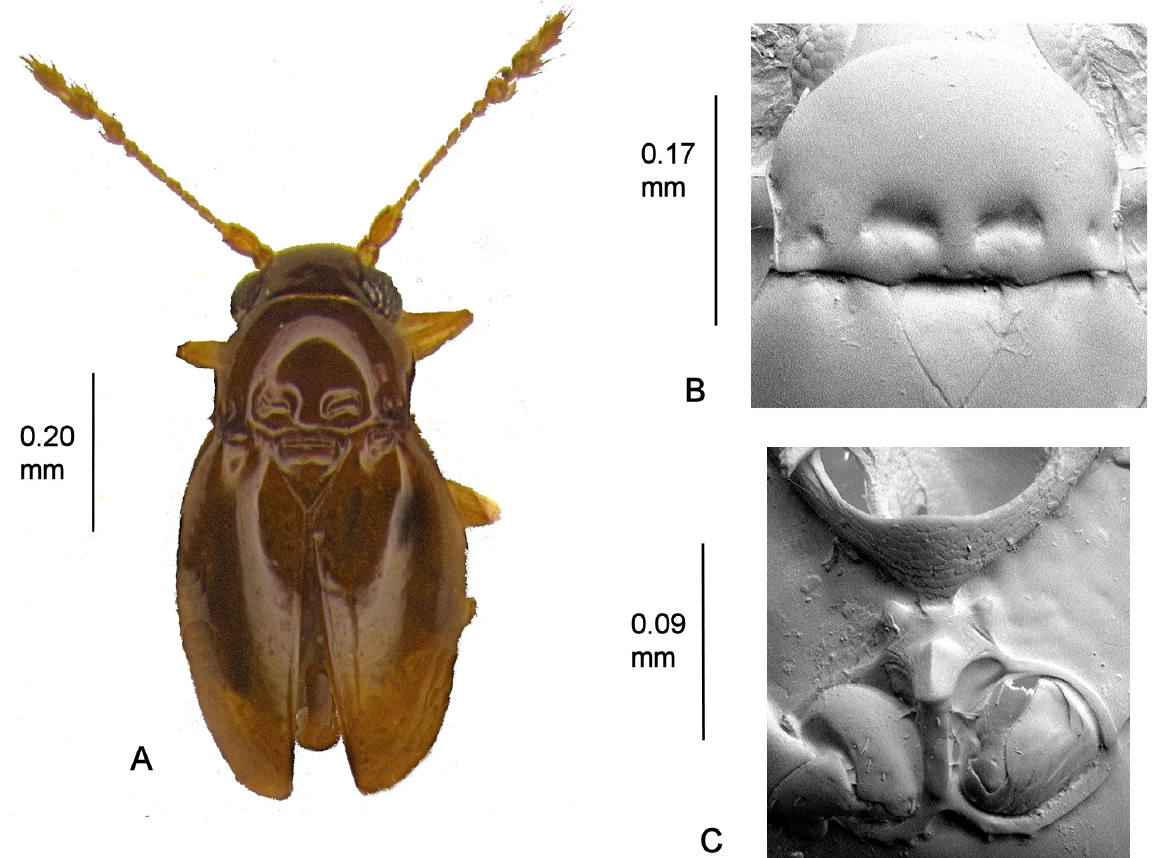
Fig. 9. Cissidium franzi sp. nov. A . Habitus. B . Pronotum, × 630. C . Mesoventrite showing median process of collar, mid-keel and keel, ×